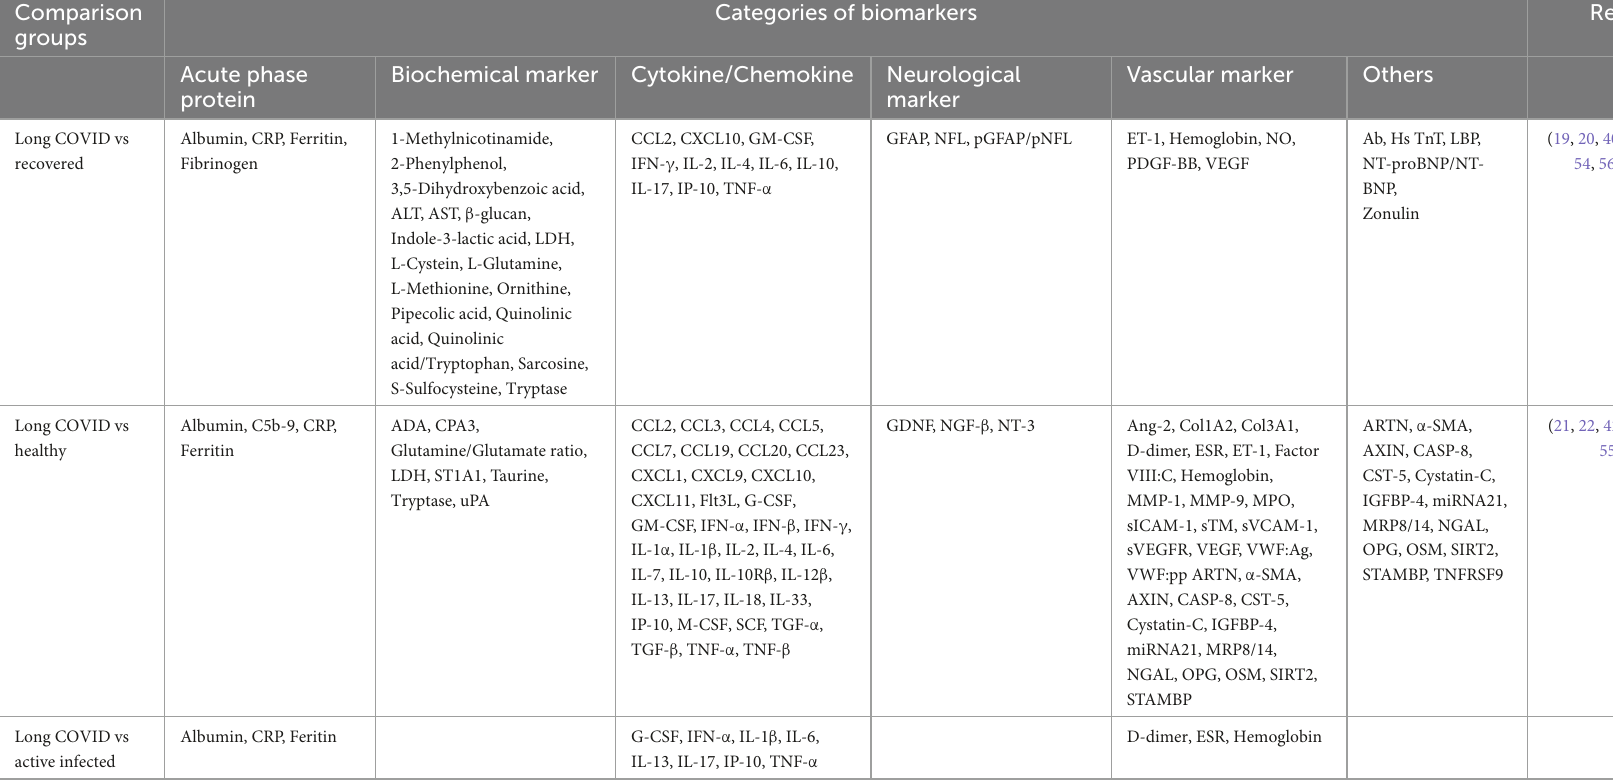
TABLE 2 Biomarkers significantly associated with different comparison